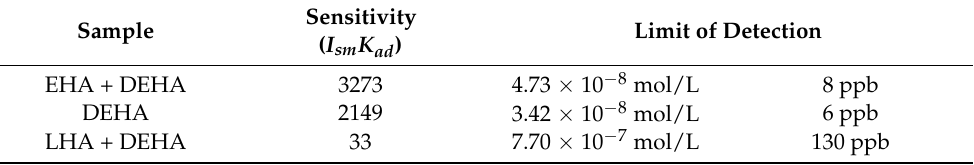
Table 1. Analytical parameters obtained from the calibration curve and used in the LOD